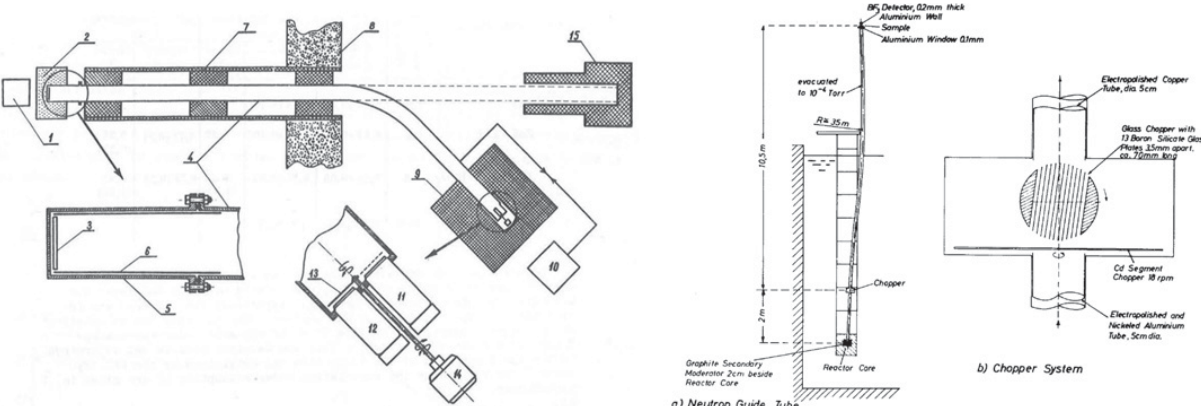
Figure 2. The first production of ultra-cold neutrons as an episode during the era of the cold war. Left : experiment of the east, the Dubna experiment by V. I. Lushchikov et al. [1]. The neutron source was the IBR pulsed reactor operating at an average power of 6kW and with a flash repetition frequency of one every 5 sec. The only neutrons that could reach the detector in the bent tube in practice were those emitted from moderator labeled 3 with velocities lower than 5.7m/s for copper [1]. Right : experiment of the west, the Munich experiment by A. Steyerl [2]. Very cold neutrons were selected from the spectrum of a graphite secondary moderator near the core of the FRM reactor through a vertical neutron guide tube and energy-analysed with the time-of-flight method. Total cross sections for gold and aluminium at 300K were measured for neutron velocities down to